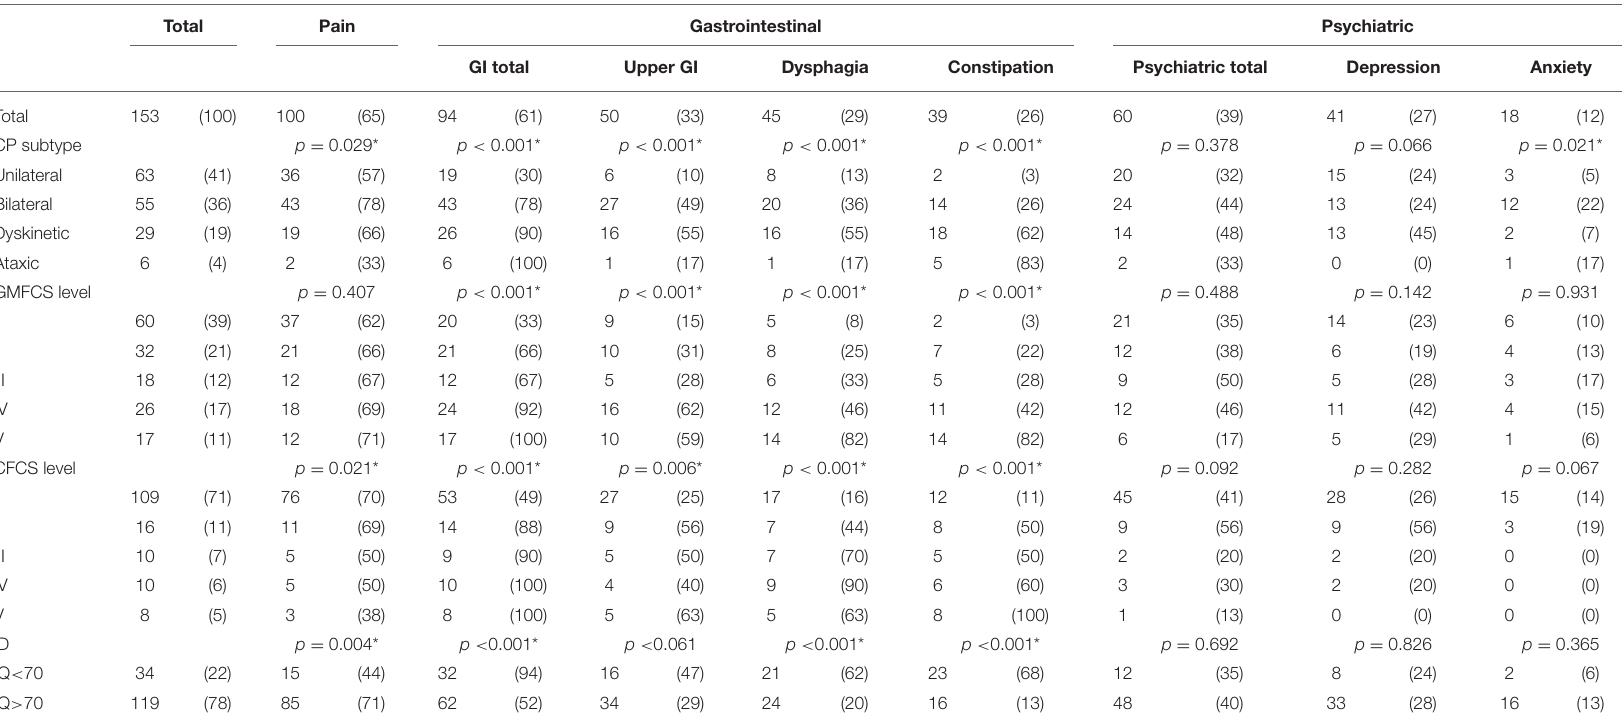
TABLE 2A | Health conditions in adults with CP, by CP subtype, GMFCS level, CFCS level, and ID ( n =